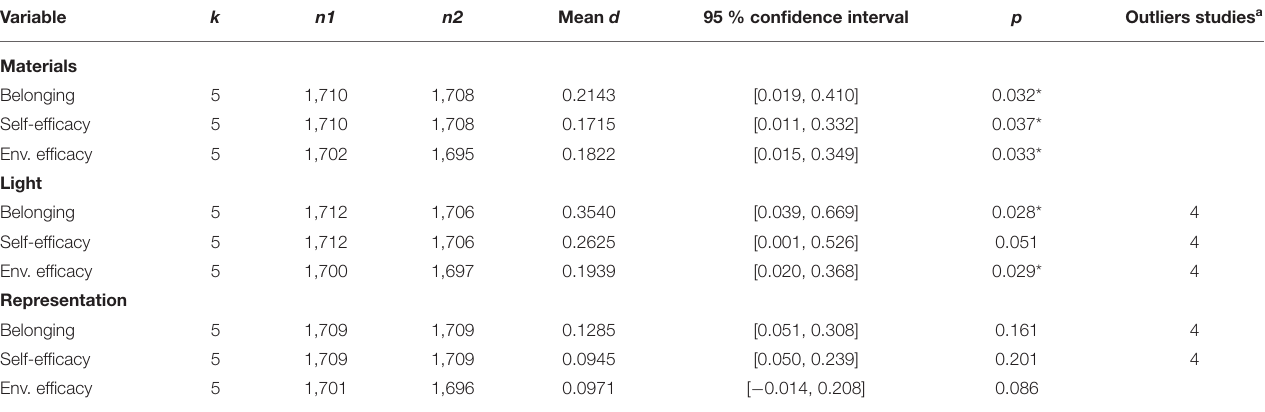
TABLE 10 | Summary results of the